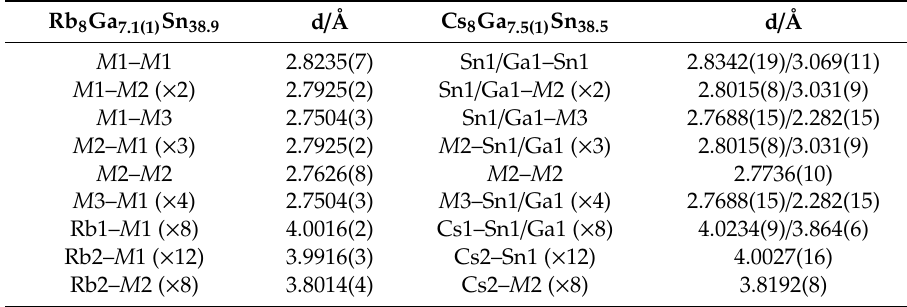
Table 3. Selected interatomic distances (Å) for Rb 8 Ga 7.1(1) Sn 38.9 and Cs 8 Ga 7.5(1) Sn 38.5 . M denotes the mixed occupied Sn / Ga